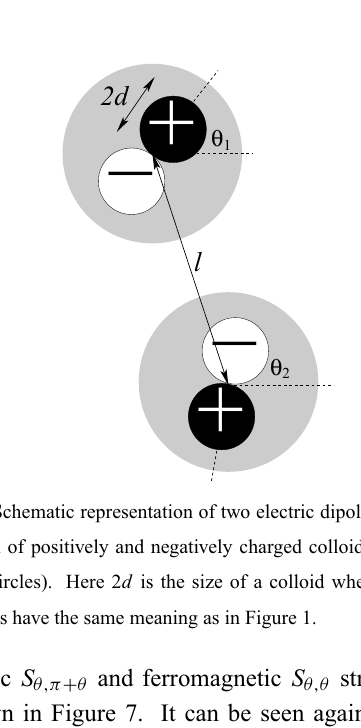
Fig. 4 – Same as Figure 3 but on a triangular lattice with (a) κ l = 6, α = 1 and (b) κ l = 6, κ d = 1. In the equilateral configuration ( α = 1), tetrapartite ground state configurations appear for flexible dimers with large κ d (shaded region in a)). A typical tetrapartite configuration (disks) with enlarged unit cell is shown in the inset along with the “rigid” bipartite configuration (lines) for comparison.